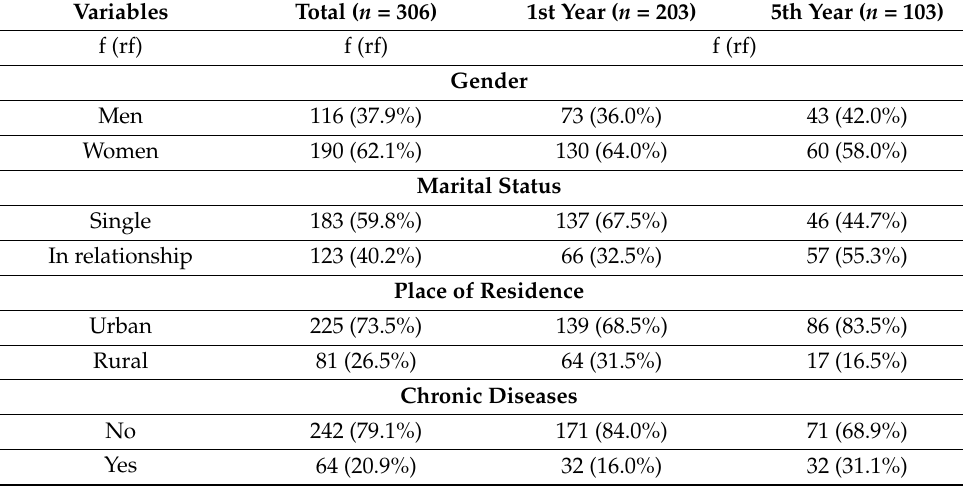
Table 1. Demographic characteristics of the sample.